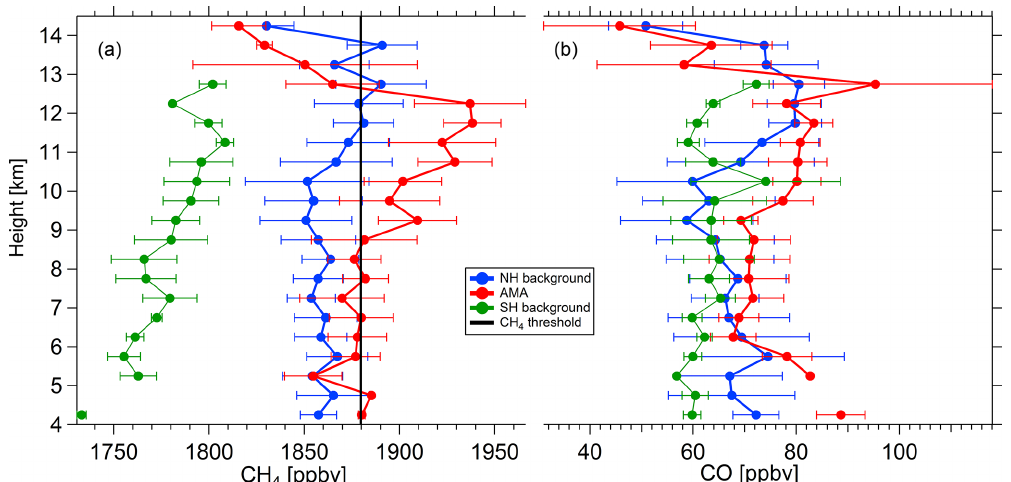
Figure 2. Average profiles for the Northern Hemisphere (NH) background, the AMA, and the Southern Hemisphere (SH) background for CH 4 ( a ) and CO ( b ); profile locations are presented in Fig. 1. The CH 4 threshold (1879.8ppbv) is indicated by the black